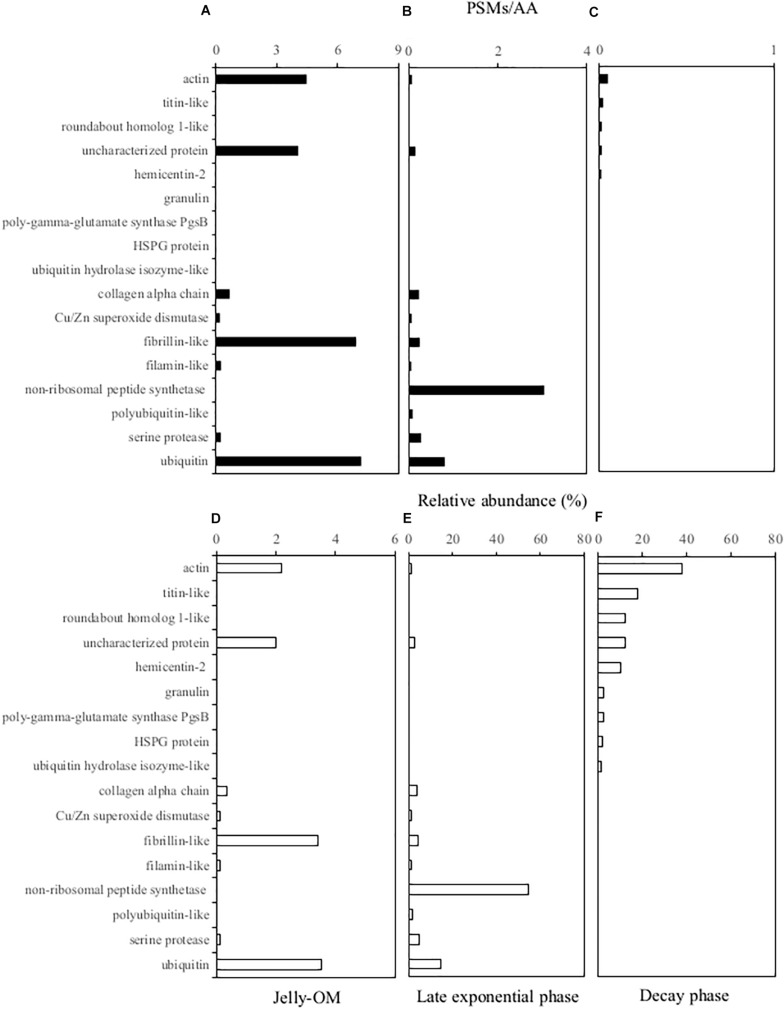
Soluble jellyfish proteins (A, D) detected in the 0.2 μm–5,000 Da fraction of the media at the beginning of the experiment in the jelly-OM treatments (B, E) in the late exponential phase and (C, F) in the senescent phase of the bacterial growth. For each peptide the absolute peptide spectrum matches/number of amino acid residuals (PSMs/AA) value is provided (A–C) and its relative abundance (D–F) is calculated as the percentage of all the jellyfish proteins detected in the initial jelly-OM (A) and at the given time point (B, C). Only peptides >1% of relative abundance at any given time point are presented.